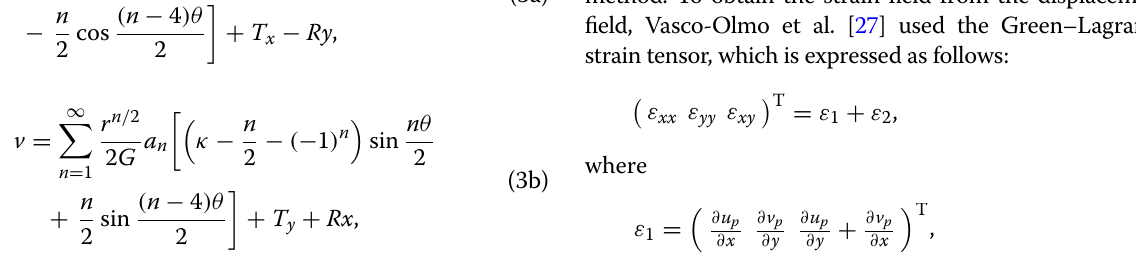
where T x , T y , and R represent translation in the x direc- tion, translation in the y direction, and rotation of the sample, respectively. Because Eq. (3) uses the crack tip position as the coordinate origin, the